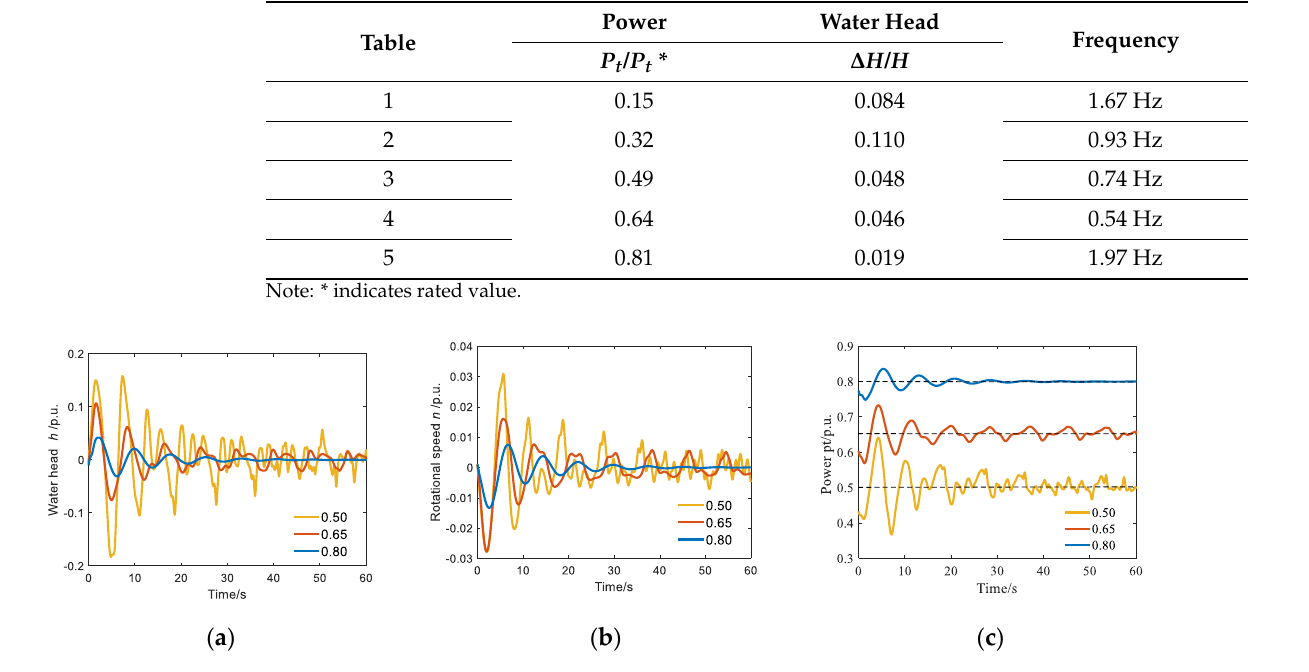
Table 1. Measured data of pressure pulsation in the draft tube of a unit with different loads.